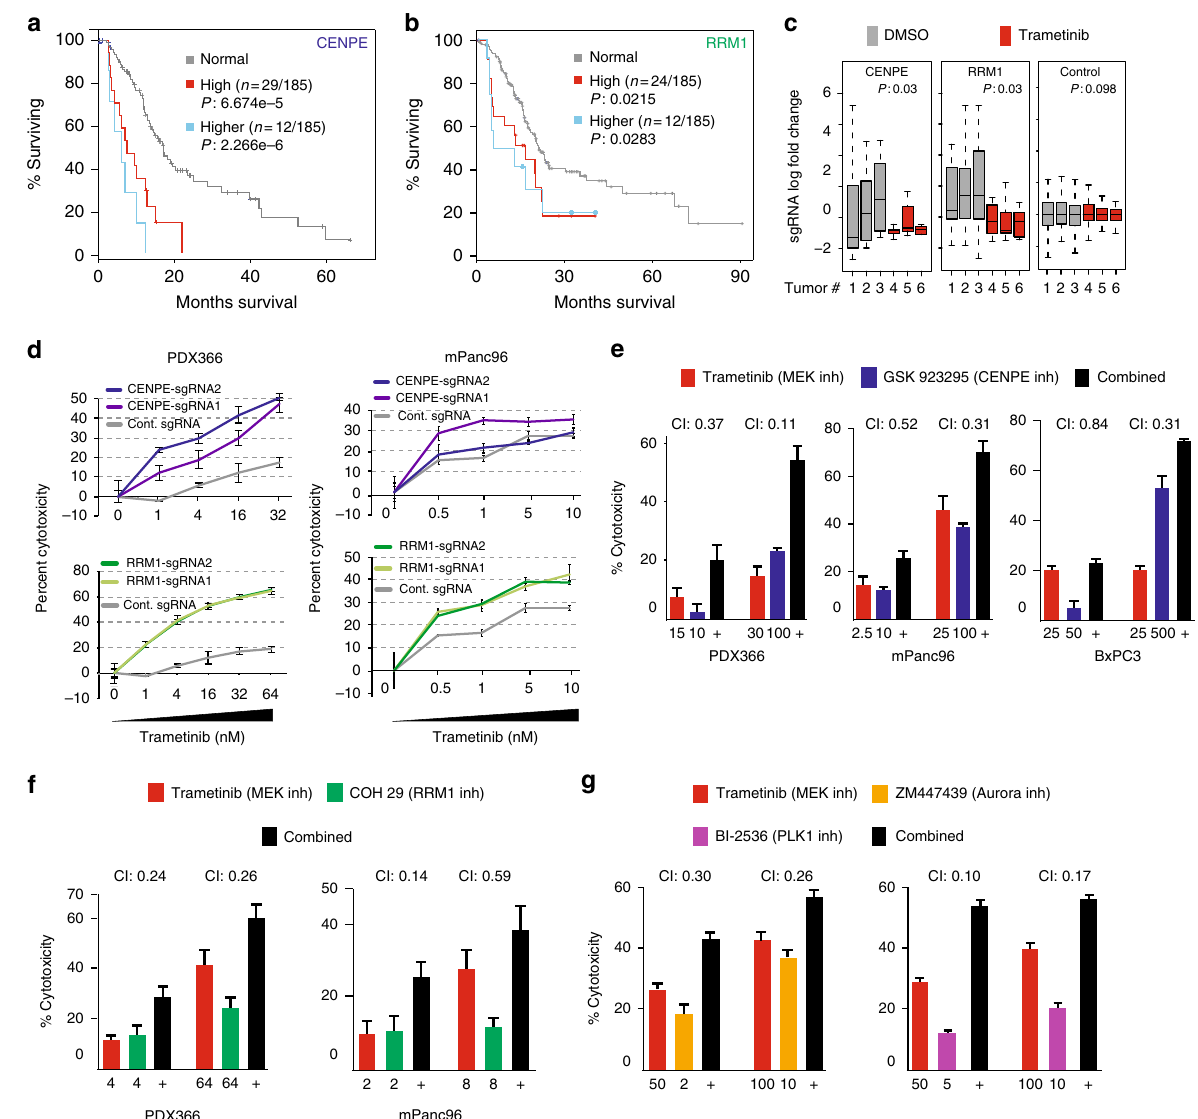
Fig. 2 The validation of CRISPR screening hits. a , b Kaplan – Meier plots showing the survival analysis of TCGA data for pancreatic cancer patients expressing high levels of CENPE and RRM1 genes. High expression: >1 standard deviation (SD), and higher expression: >2 SD above the population mean. The number of patients in each group is indicated with n . c Box plots show fold change distribution of sgRNAs targeting CENPE ( n = 10), RRM1 ( n = 10), and control sgRNAs ( n = 100) in tumors from control-treated and trametinib-treated mice. Bounds of the box spans from 25 to 75% percentile, center line represents median, and whiskers visualize 5 and 95% of the data points. Signi fi cance was assessed by Kolmogorov – Smirnov test. d MTT assay-based relative viability/growth inhibition levels are shown in PDX366 and mPanc96 cells expressing WT Cas9 with control sgRNA or two separate sgRNAs targeting CENPE (top) and RRM1 genes (bottom). e Relative viability/growth inhibition levels are shown for three different cell lines, PDX366, MPANC-96, and BxPC3 cells, treated with control, MEK inhibitor (trametinib), CENPE inhibitor (GSK923295), and combined MEK inhibitor and CENPE inhibitor. f RRM1 inhibitor (COH29) and trametinib were tested together in PDX366 and MPANC-96 cells. g Bar plots show relative growth inhibition of MPANC-96 cells treated with inhibitors of Aurora A/B (ZM447439) and PLK1 inhibitor (BI-2536) alone or in combination with trametinib. Each experiment was repeated at least three times and error bars represent the standard error of the mean value. CI cytotoxicity index, Comb combination of two